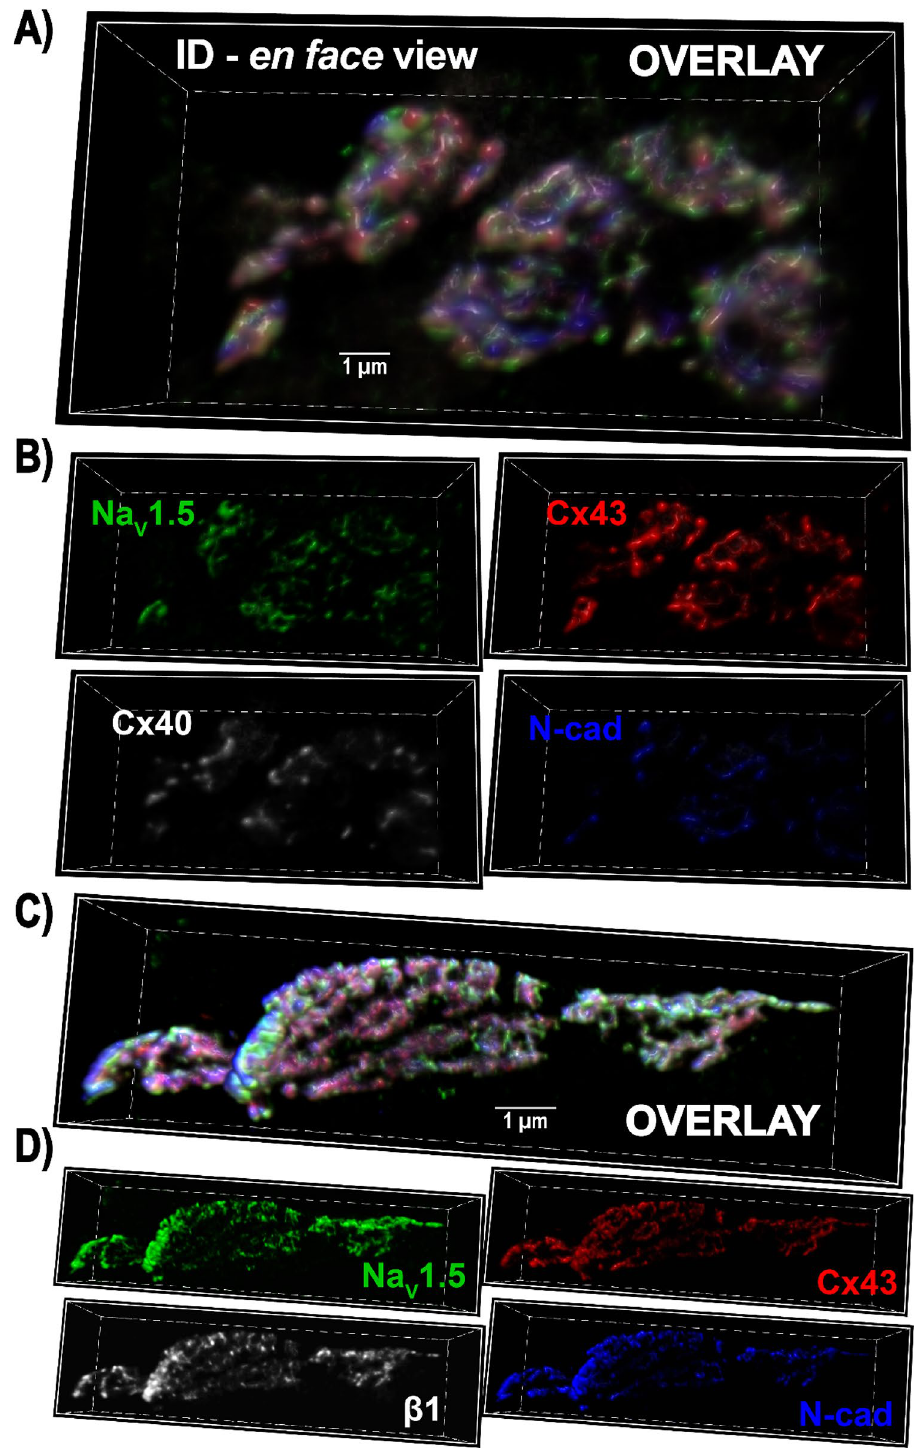
Figure 4. sDCI imaging of IDs. Representative 3D sDCI images of en face IDs from murine atria immunolabeled for (A, B) Na V 1.5, Cx40, Cx43, and N-cad, and (C, D) Na V 1.5, β1, Cx43, and